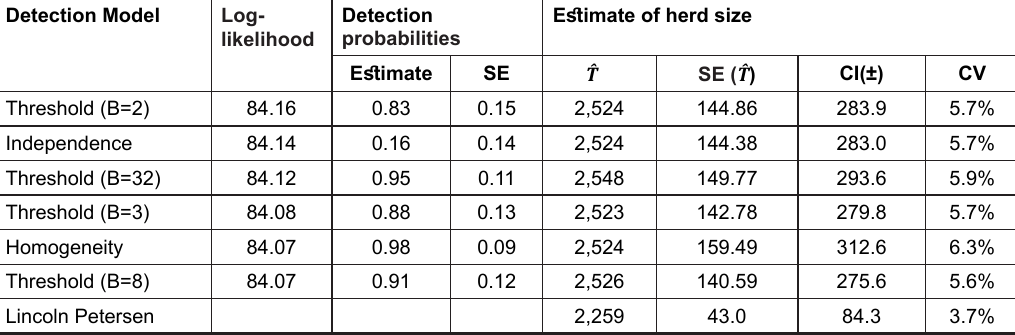
Table 34. Rivest model estimates and LP estimate for the Cape Bathurst 2015 post calving survey.